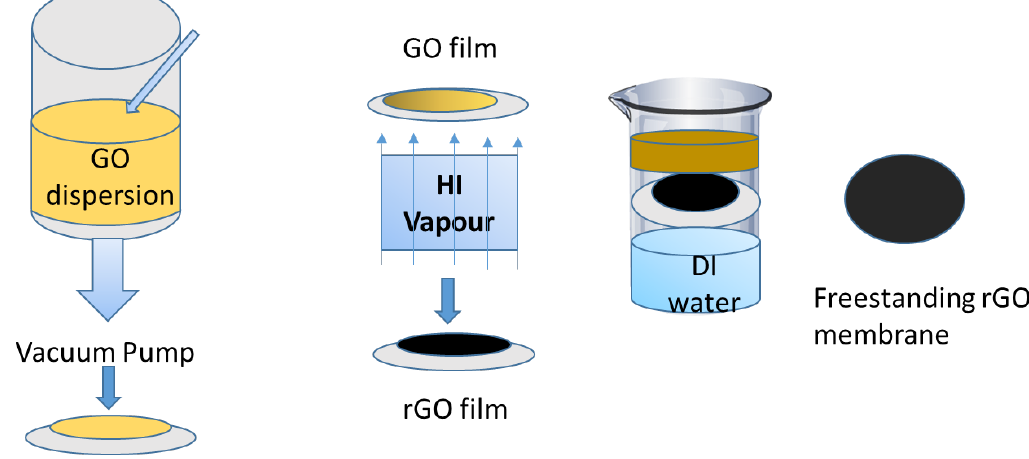
Figure 9. Fabrication of reduced graphite oxide (rGO) for water treatment [48].